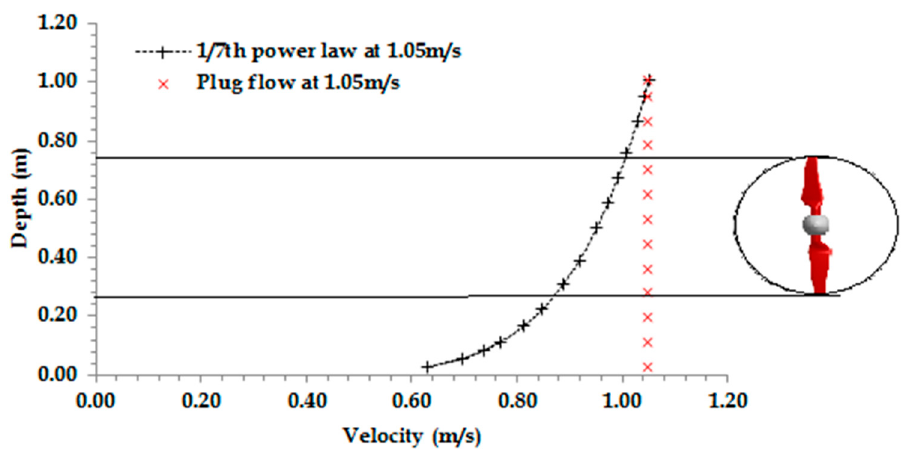
Figure 6. Inlet velocity profile with 1/7th power law and plug flow for the experimental channel.